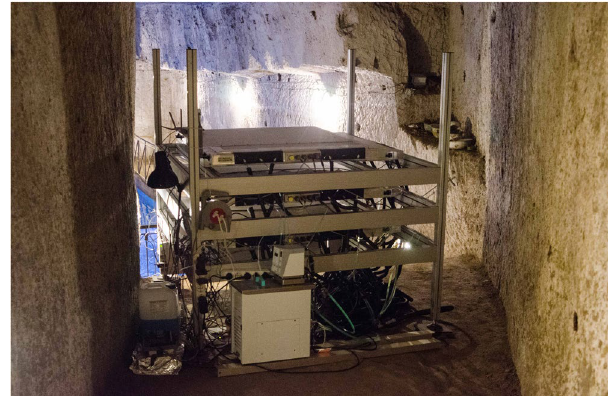
Figure 3. The detector in a recess of the cavity facing the water cistern.